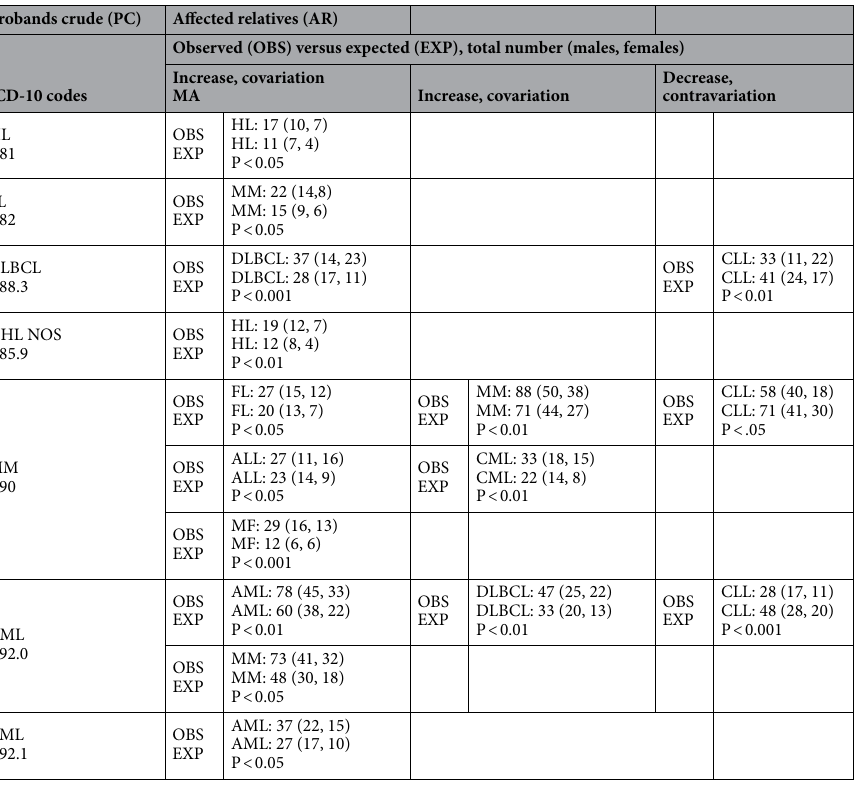
Table 3. Co- and contravariation of affected relatives to probands crude with familial malignant blood disorders (the Faroe Islands). Diagnosis abbreviations: Cf. TABLE 1. OBS: Number of patients observed. EXP: Calculated number of patients using prevalence given in Table 1. Covariation: OBS > EXP. Contravariation: OBS <